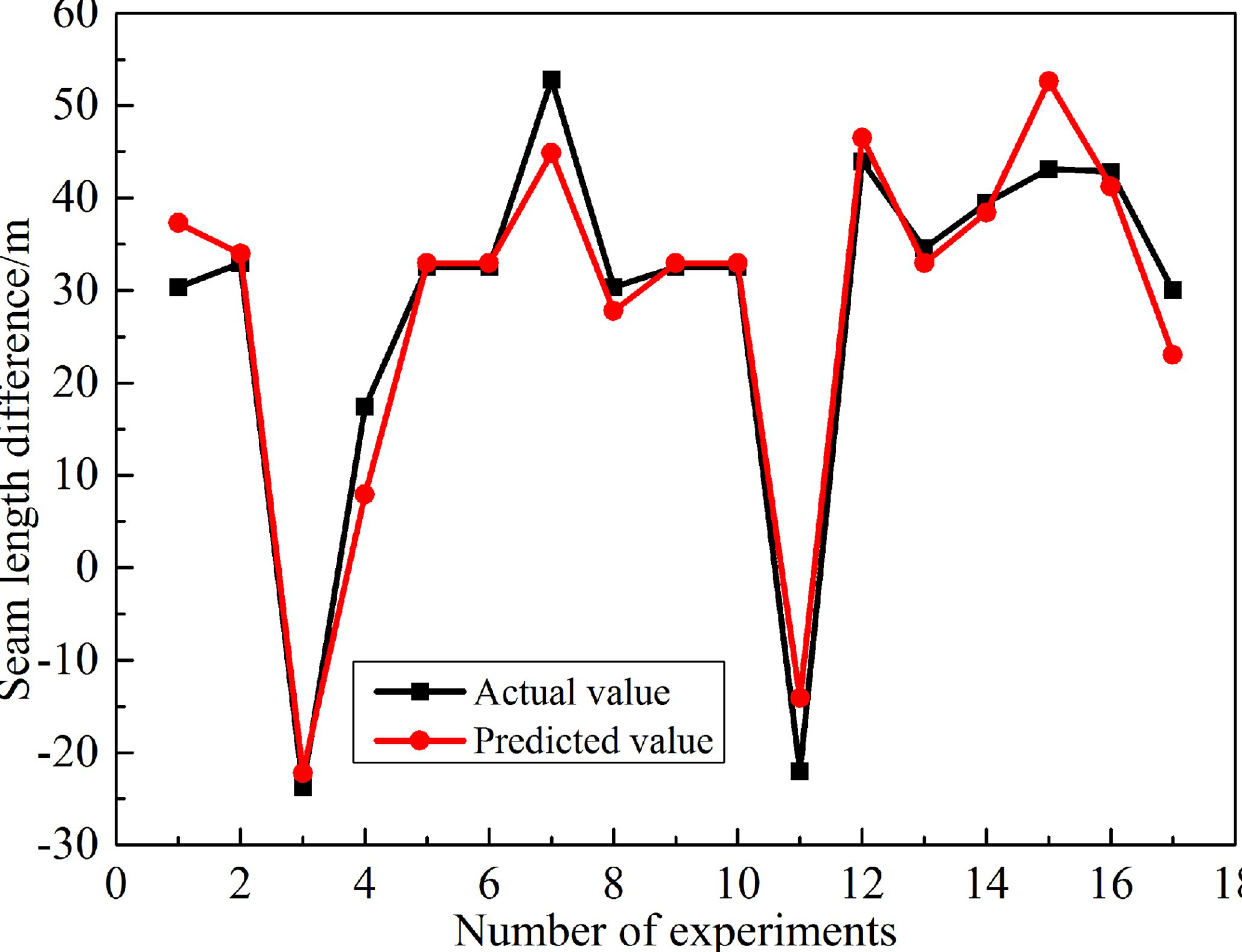
Fig 12. The regression equation compares the predicted value with the actual